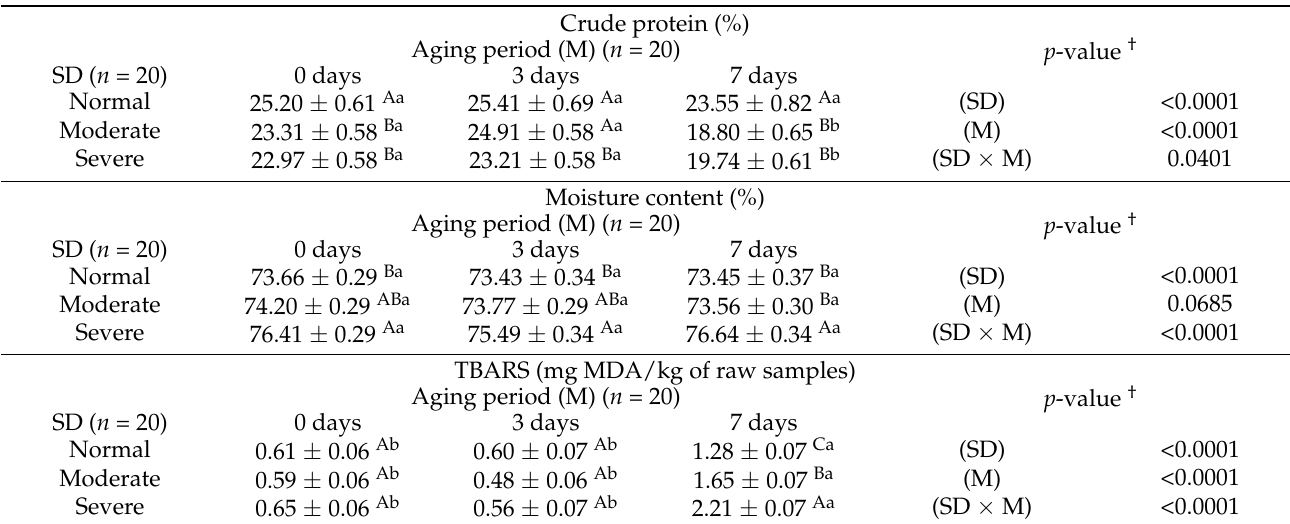
Table 5. Mean values of crude protein, moisture content, and lipid oxidation (TBARS) of the breast meat from broilers affected by wooden breast myopathy maturated for up to 7